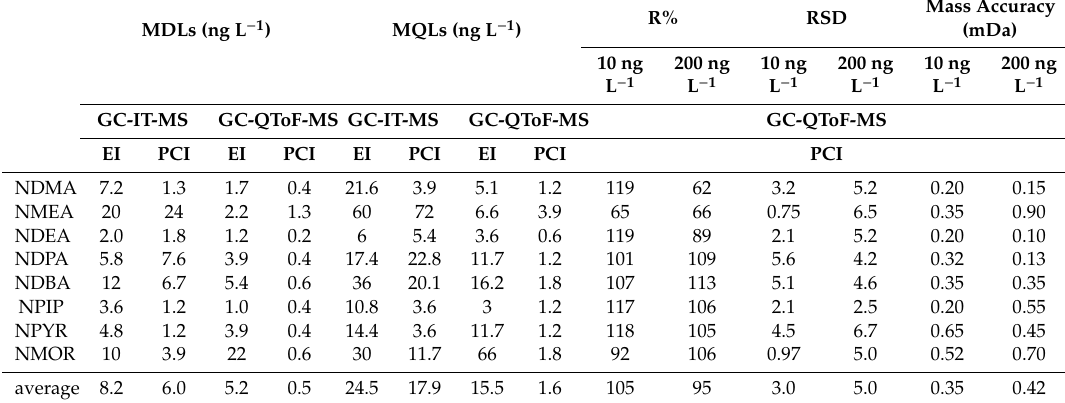
Table 3. Accuracy of the method detection limit (MDL) and method quantification limit (MQL), expressed as recoveries (R%), intra-day precision (expressed as RSD), and mass accuracy (average error in mDa) obtained from a spiked (10 ng L − 1 and 200 ng L − 1 ) wastewater e ffl uent